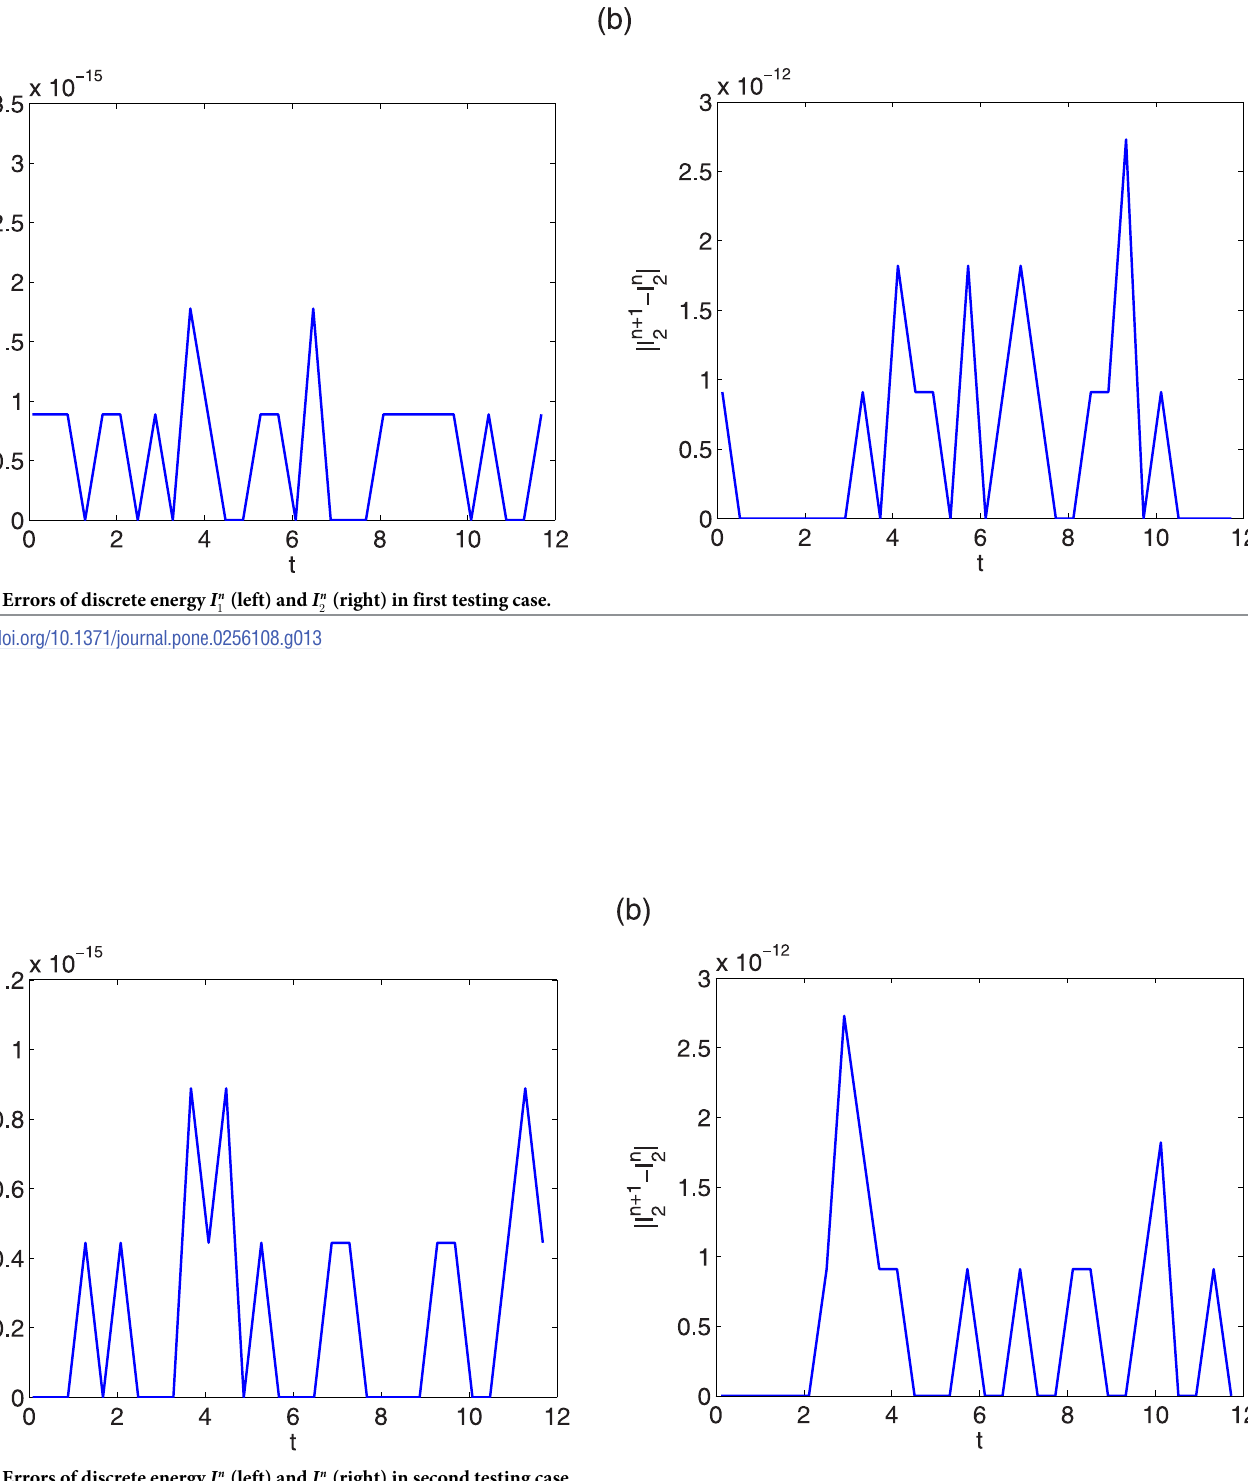
(left) and I n (right) in second testing case. 1 2